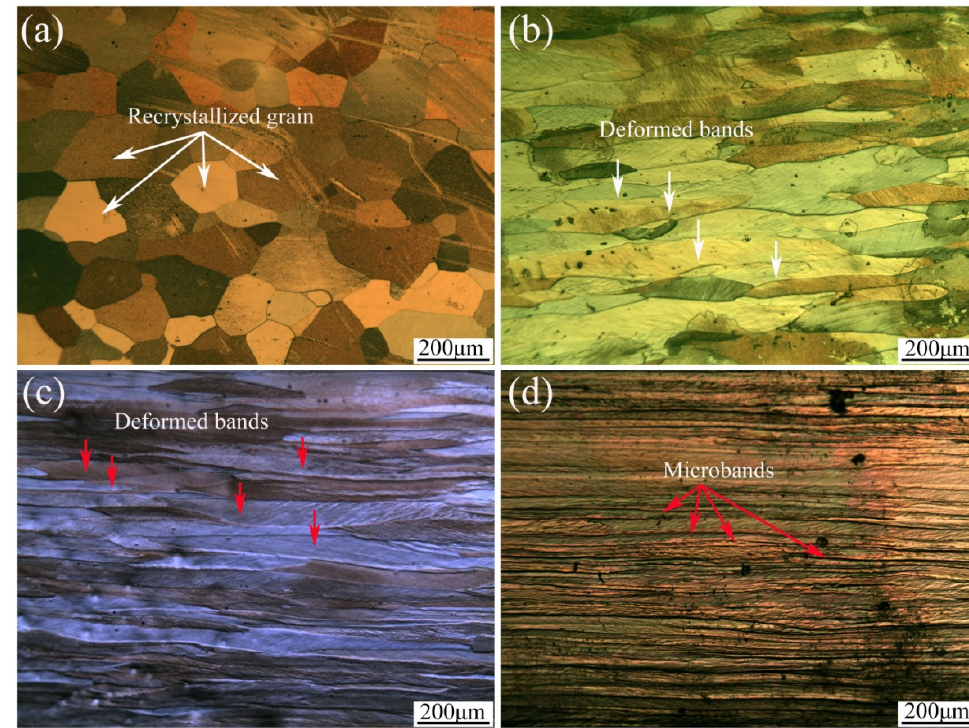
Figure 2. Polarized microstructuresof ( a ) as-received; ( b ) CR-50%; ( c ) CR-70%; ( d ) CR-85%. Grain size, microstructure and hardening of high-purity aluminum plates during the cold rolling process were studied. It can be seen that with an increase in CR deformation degree, the grains are flattened, elongated, or even broken, and dislocations, subgrains and other defects also gradually appear. Figure 3 shows the grain orientation images and grain boundary structures of aluminum plates with different cold rolled shape variables. Grain orientation image and grain boundary structure diagrams show that with the increase in CR deformation, grain orientation gradually shifts from (001) plane texture to (101) and (111) plane texture, and the proportion of low-angle grain boundaries (LABs) 0~10° becomes larger (shown in Figure 3b–d). This shows that the misorientation angles between adjacent grains are LABs after the grains are flattened and crushed. When the CR deformation increases to a higher degree, the main texture type is the (101) plane rolling texture, the grains are completely broken, and the grain boundary structure shows that most of the grain boundaries are LABs, and the misorientation angle is distributed between 0~20 ◦ .